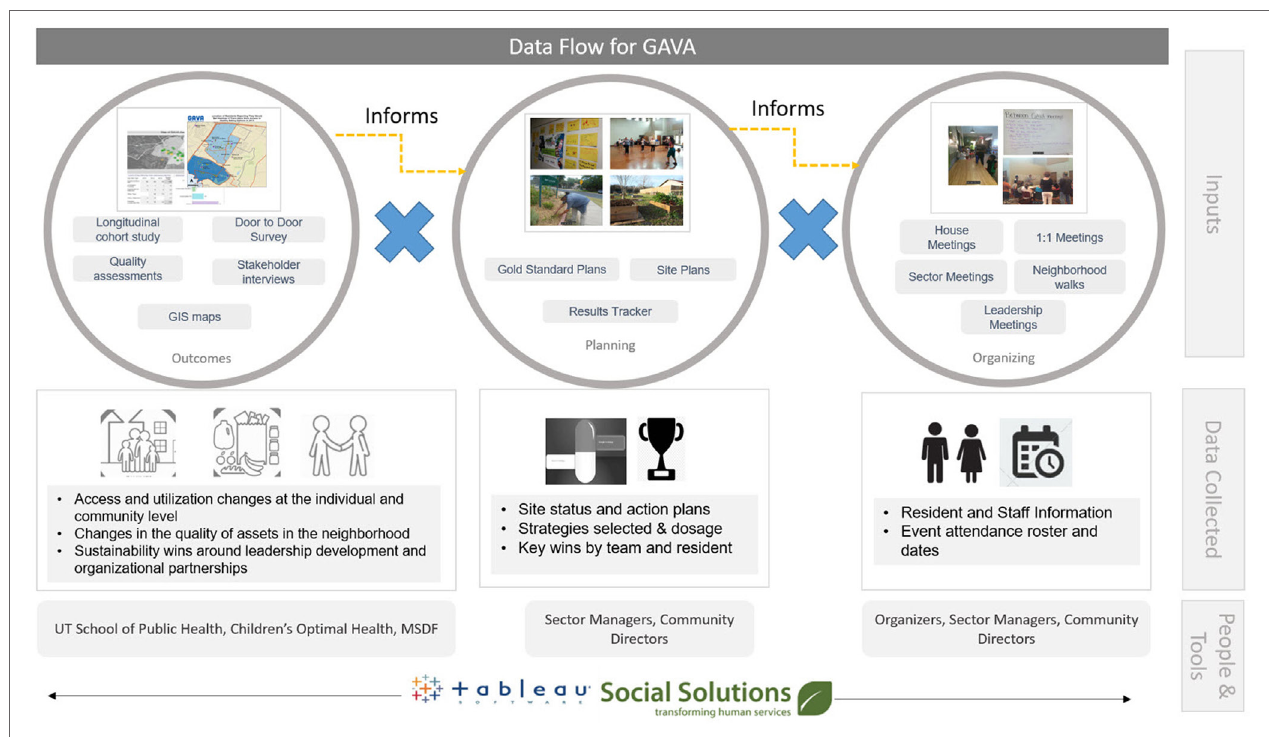
FiGuRE 2 | Flow of evaluation and process data within